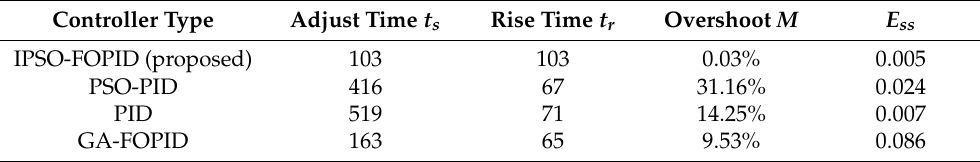
Figure 14. Course-keeping curves without disturbance. Table 5. Performance of four different